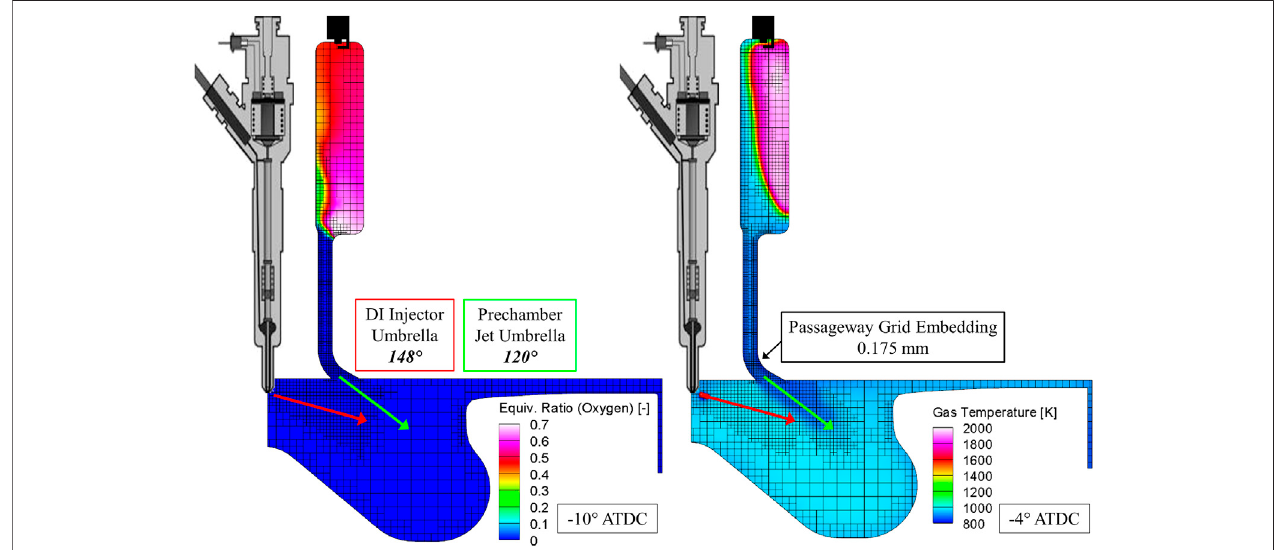
FIGURE5| IllustrationoftheCFDmodelingsetupfortheprechamberenabledmixingcontrolledcombustion(PC-MCC)simulationswithD pass (cid:1) 1.5 mmandH pc (cid:1) 20 mm (Left) Vertical cut plane on the spray axis colored by oxygen-based equivalence ratio at PC spark timing (Right) Vertical cut plane on the spray axis colored by gas temperature at the start of DI